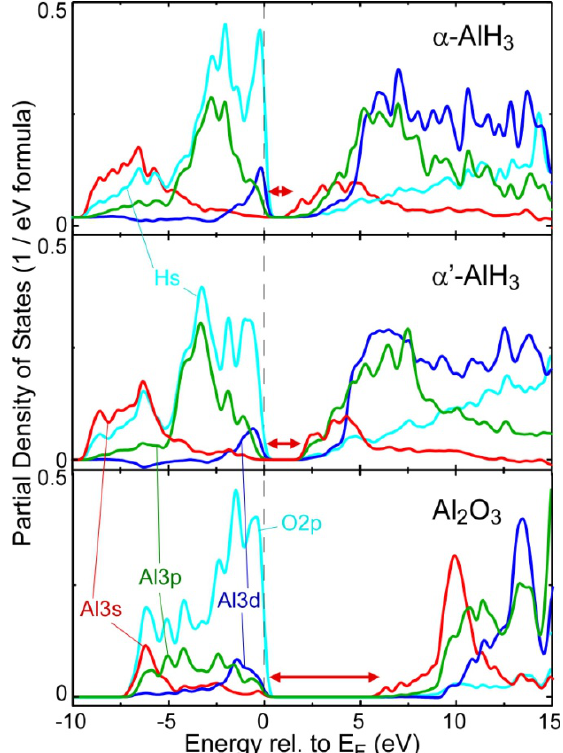
Figure 2. Calculated partial density of states (PDOS) for α -AlH relative to the Fermi level. The double-headed arrows indicate the band gaps of the electronic